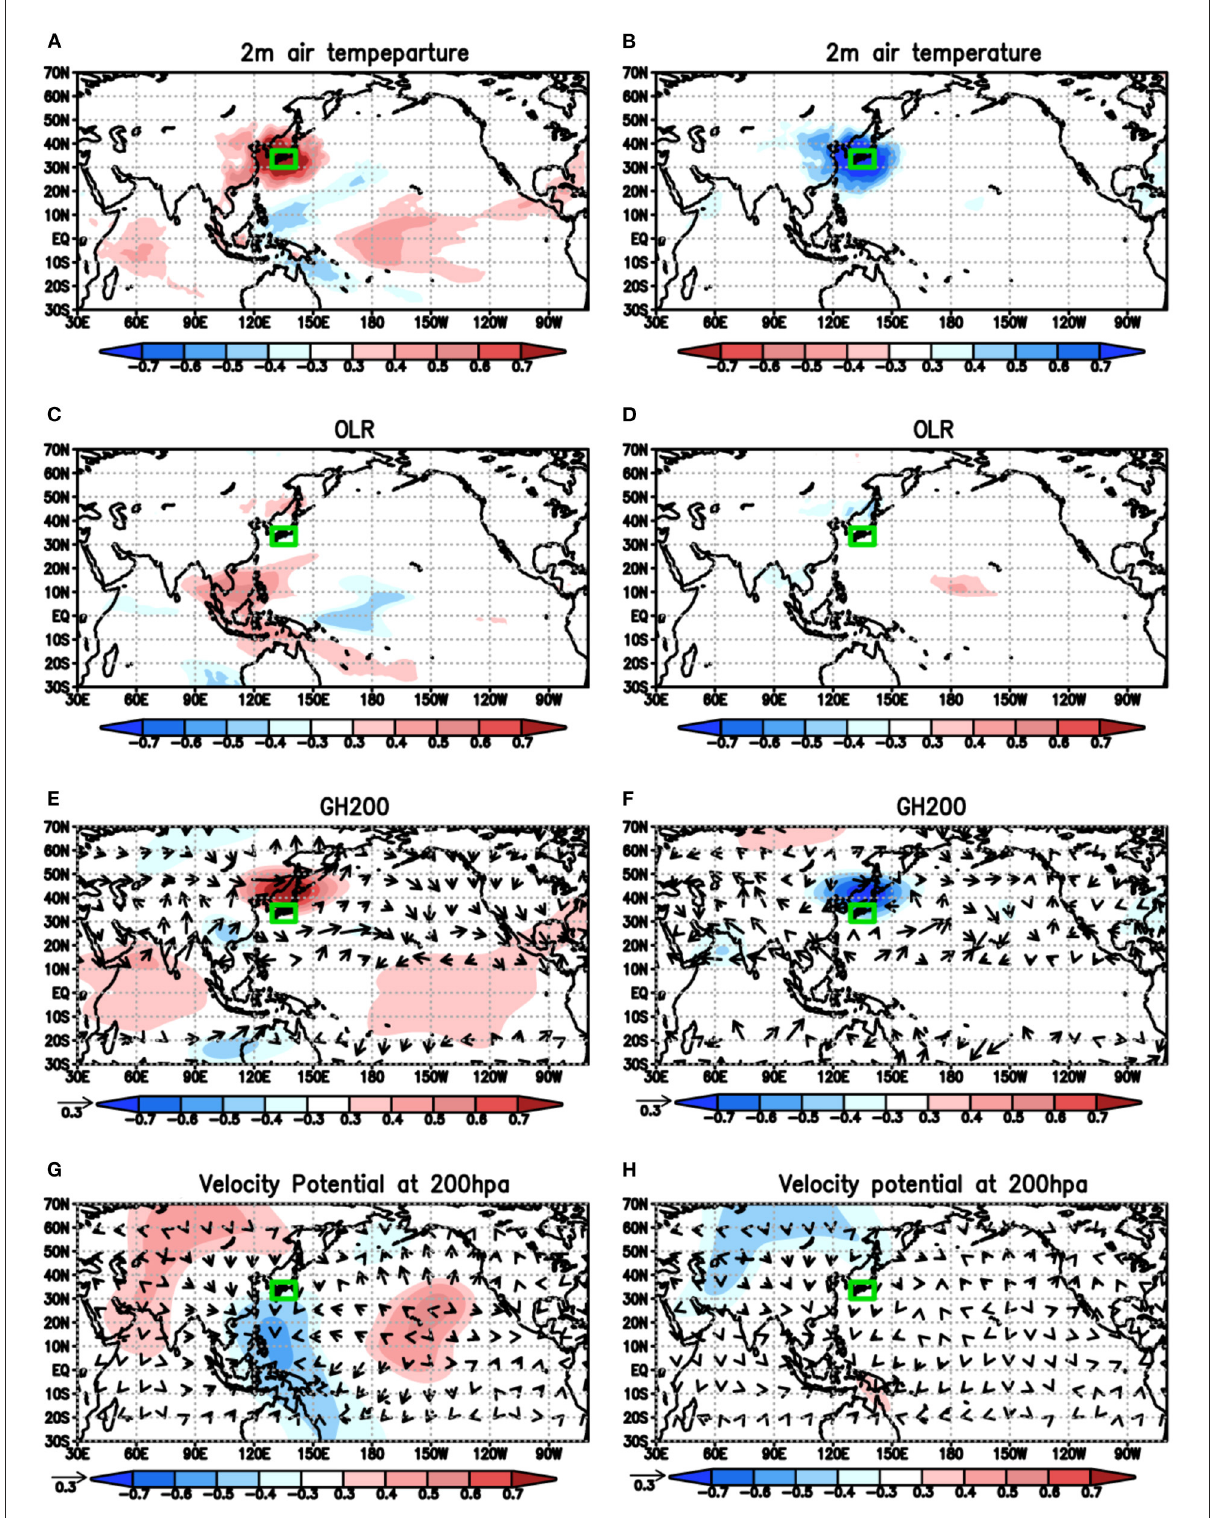
FIGURE5 Same as Figure 3, but for December (prediction issued on issued on 1st − 9th of November) for 10 warm years (1987, 1990, 1994, 1997, 2000, 2004, 2006, 2008, 2010, 2019) and 5 cold years (1984, 1988, 1989, 2009, 2017).